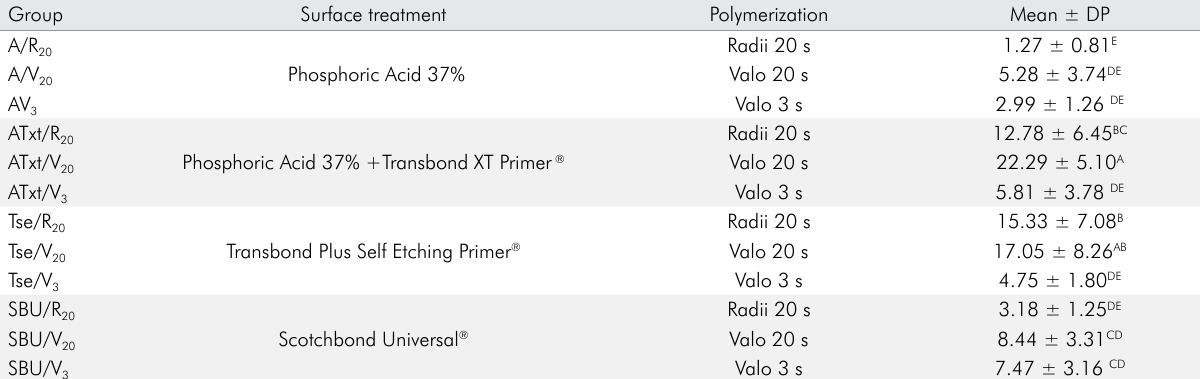
Table 3. Bond strength values (MPa) according to the factors “surface treatment” and “polymerization” (n = 10). Group